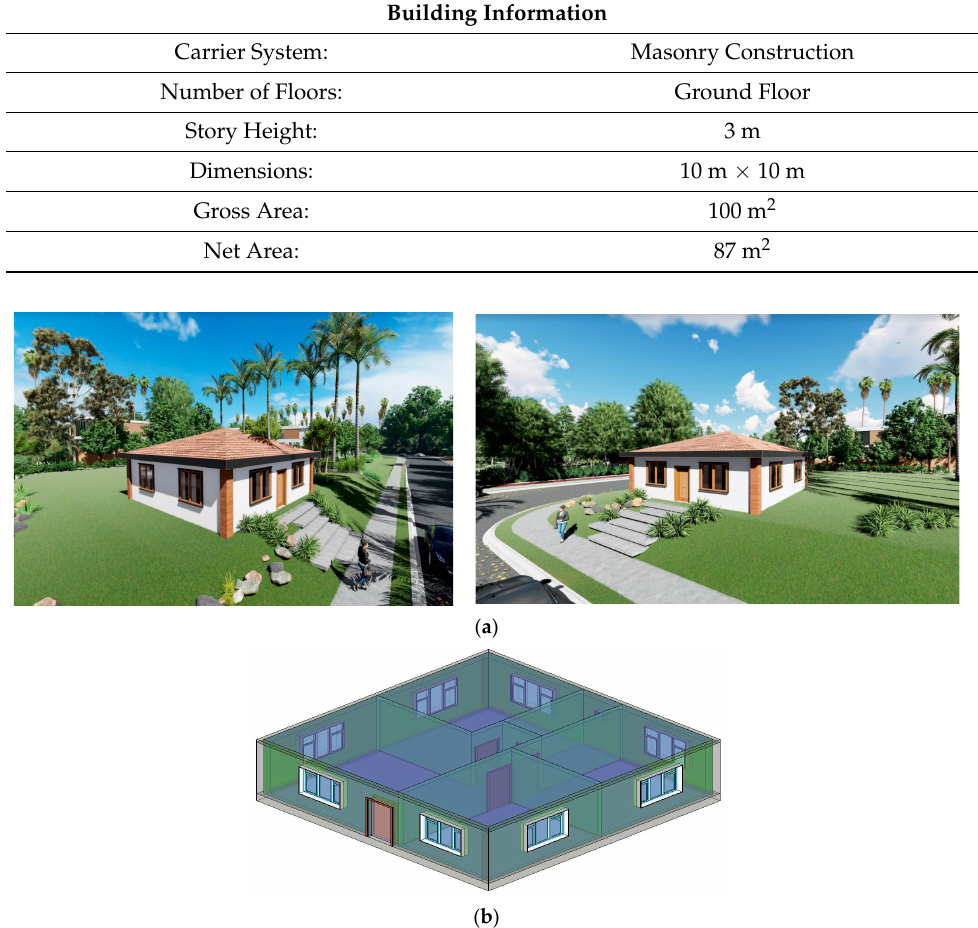
Figure 3. ( a ) The building renders obtained from Lumion software; ( b ) The building 3D view obtained from Revit. Table 4. The building information of the analyzed structure.